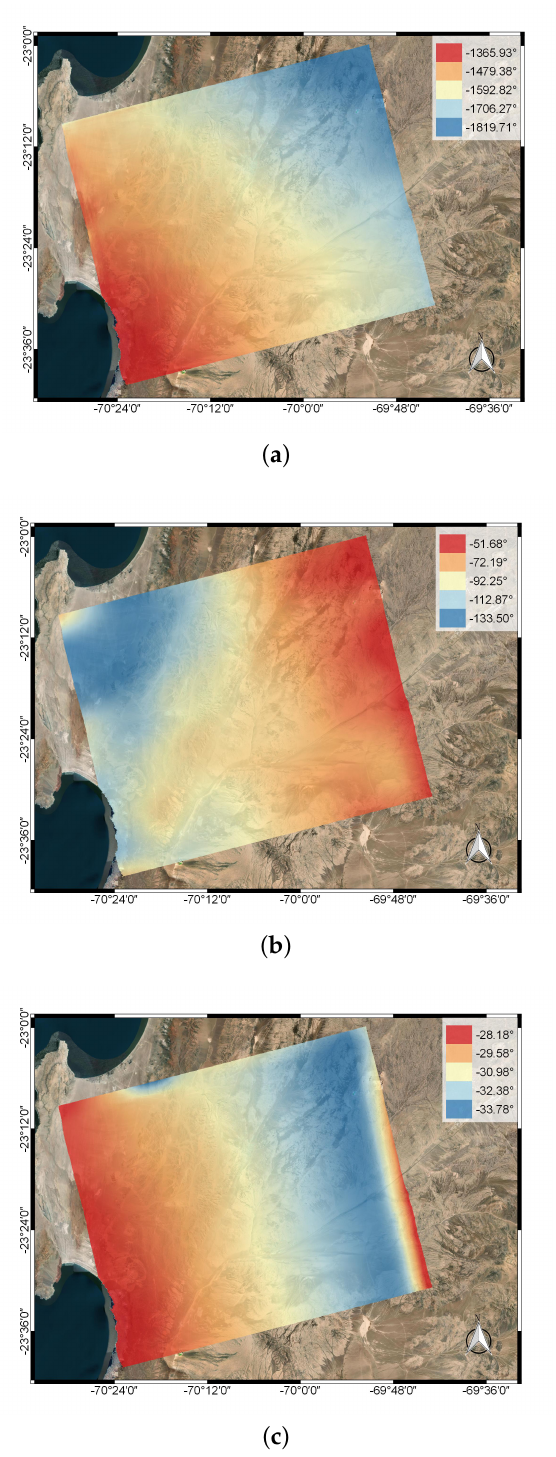
Figure 15. Ionospheric correction with baseline error by SSM on 20100623 and 20100808: ( a ) Ionospheric phase delay. ( b ) Corrected DInSAR phase. ( c ) Corrected DInSAR phase